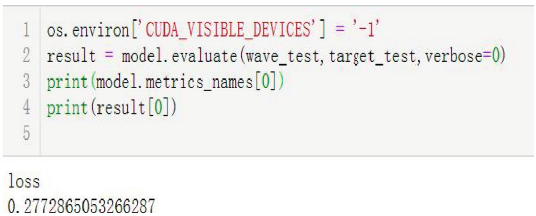
Figure 22: The prediction loss of the test sample about action idea EEG in dynamic